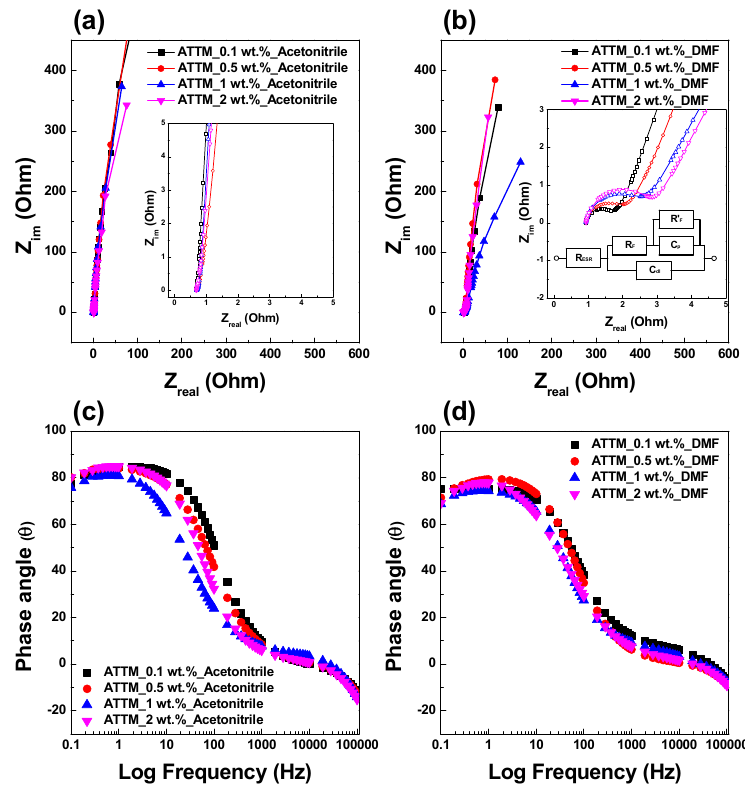
using a DC bias potential of 0.5 V at open circuit potential. As revealed in Figure 6a, only a near-vertical line was observed for the entire frequency region, without the semicircle in the high-frequency region. This indicates that the AM–CNW capacitors utilize EDLC charge storage mechanism with low ion diffusion resistance [13,85,86].